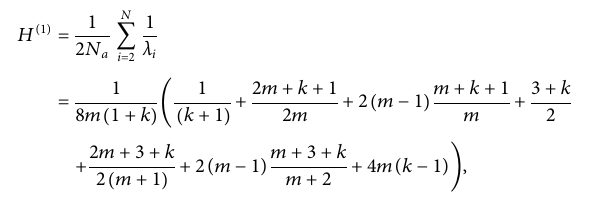
FIGURE 11 | The change of H (2) for A .